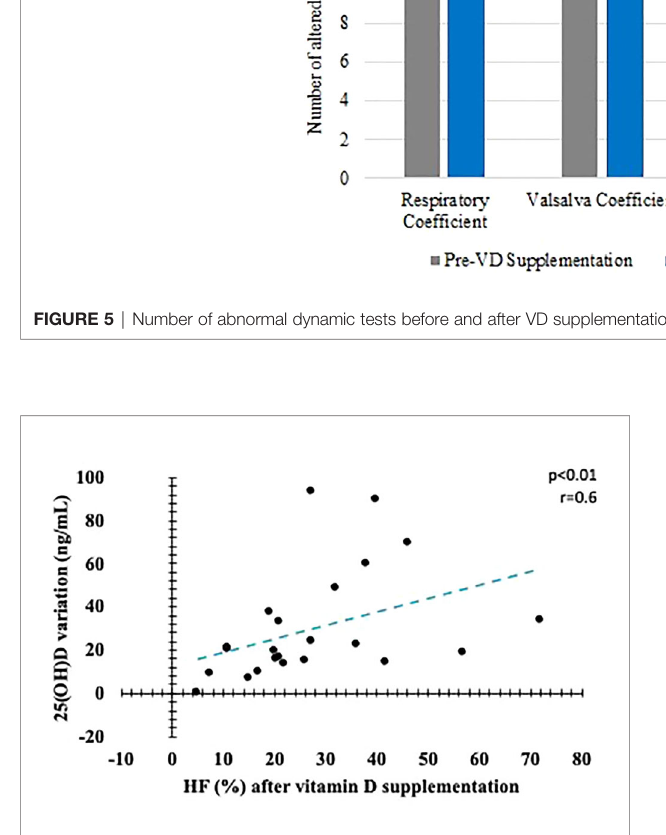
FIGURE 6 | Correlation between variation in serum vitamin D levels and fi nal HF (%). HF, High frequency .